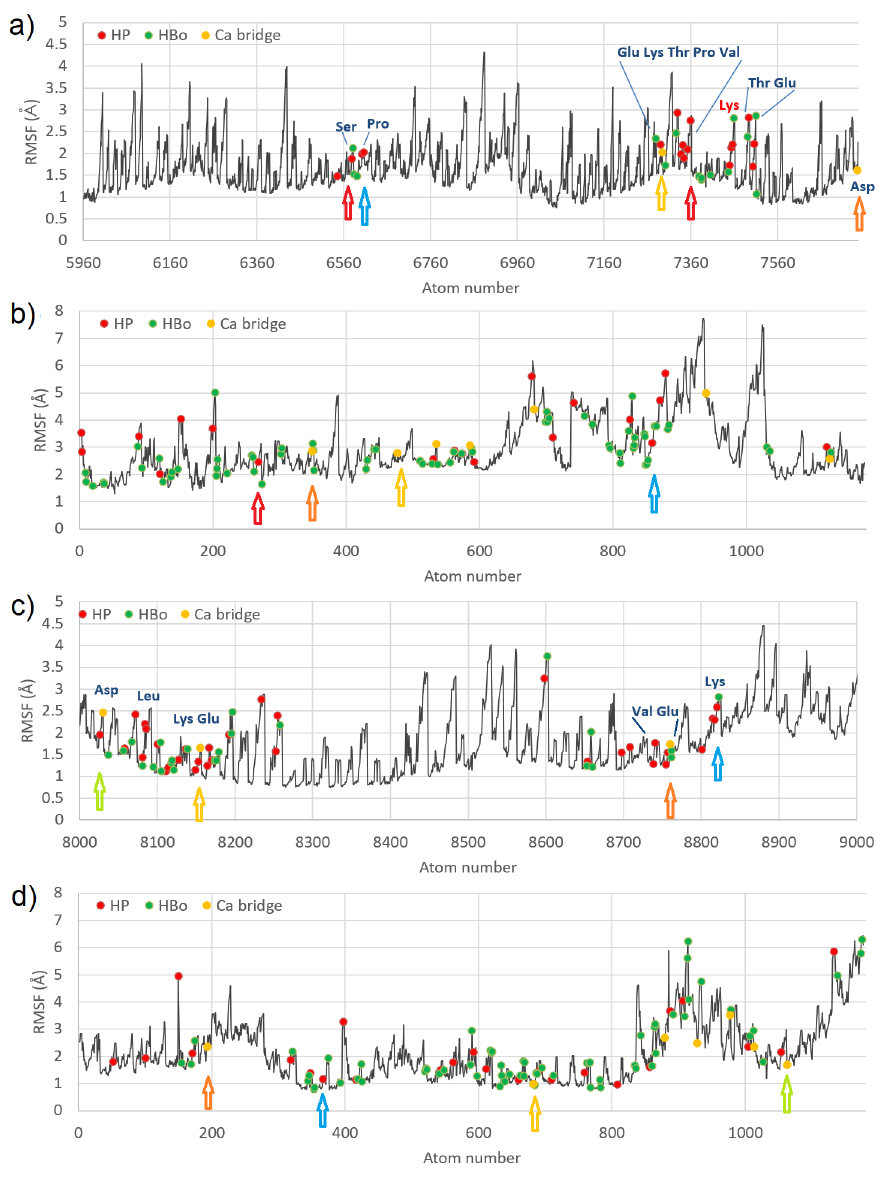
Figure 4. RMSF for best-bound domains of HSA ( a , c ) and CS ( b , d ) for complexes #2 HSA:CS-6 ( a , b ), and #3 HSA:CS-4 ( c , d ); the places of specific interactions are marked with dots. In the case of HSA:CS-6, the best-bound domain was IIIA ( a ), and for HSA:CS-4, the best-bound domain was IIIB ( c